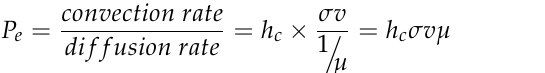
Figure 7. Armature electromagnetic force calculations when only the armature conductivity changes. The critical velocity of the numerical simulation can be stabilized under a different armature conductivity, as shown in Table 3. Under the standard armature conductivity, the critical velocity that can stabilize the numerical simulation is 503.86 m/s. The lower the conductivity, the greater the critical velocity of the stable numerical simulation. At a 40% standard armature conductivity, the critical velocity of the stable numerical simulation increases to 956.49 m/s. Table 3. Critical velocity for stable numerical simulation at different armature conductivities. Armature Conductivities Critical Velocity/(m/s) Standard armature conductivity